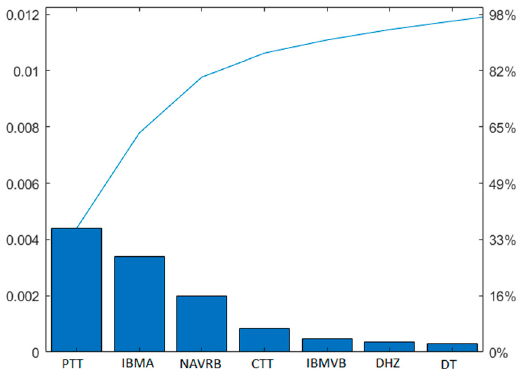
Figure 3. Selected features using the embedded feature selection technique where the line graph above the bar shows the cumulative sum of the importance values.